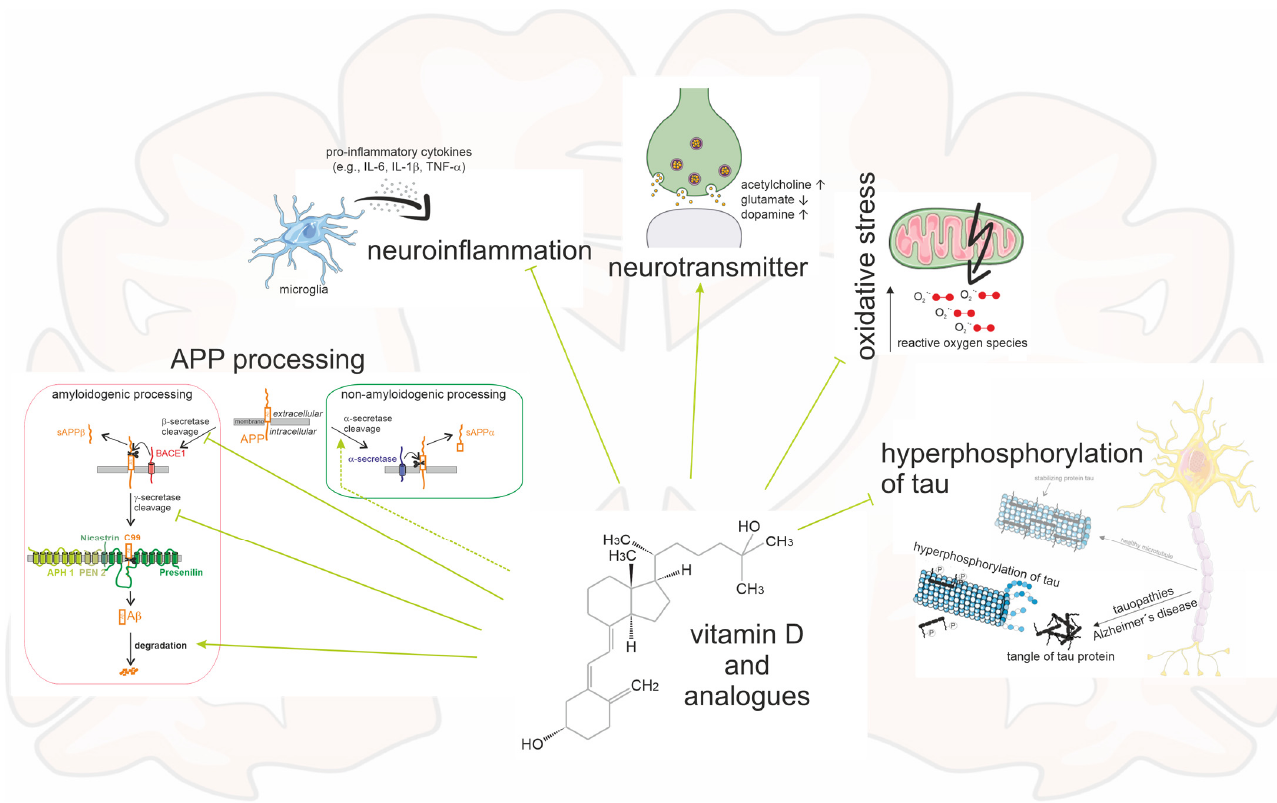
Figure 4. Schematic of an AD brain and the multiple impacts caused by vitamin D and its analogues. Vitamin D and its analogues have an inhibiting in fl uence on A β plaques by reducing the amyloidogenic processing and promoting non-amyloidogenic processing and A β degradation. Moreover, neuro fi brillary tangles, oxidative stress, and neuroin fl ammation are diminished. The neurotrans- mi tt ers acetylcholine and dopamine are enhanced, and glutamate is degraded.